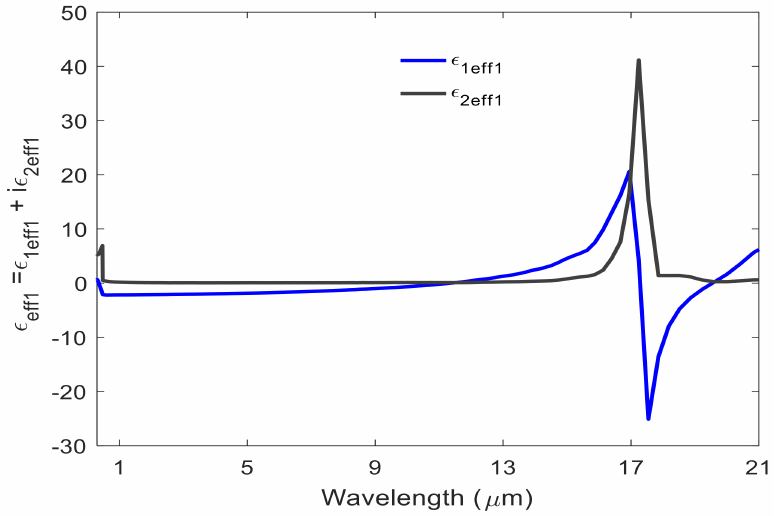
Figure 2. Real part ε 1 ef f 1 and imaginary part ε 2 ef f 1 of the dielectric constant ε ef f 1 of Ni − Al 2 O 3 (bottom) at the filling fraction of 0.8.